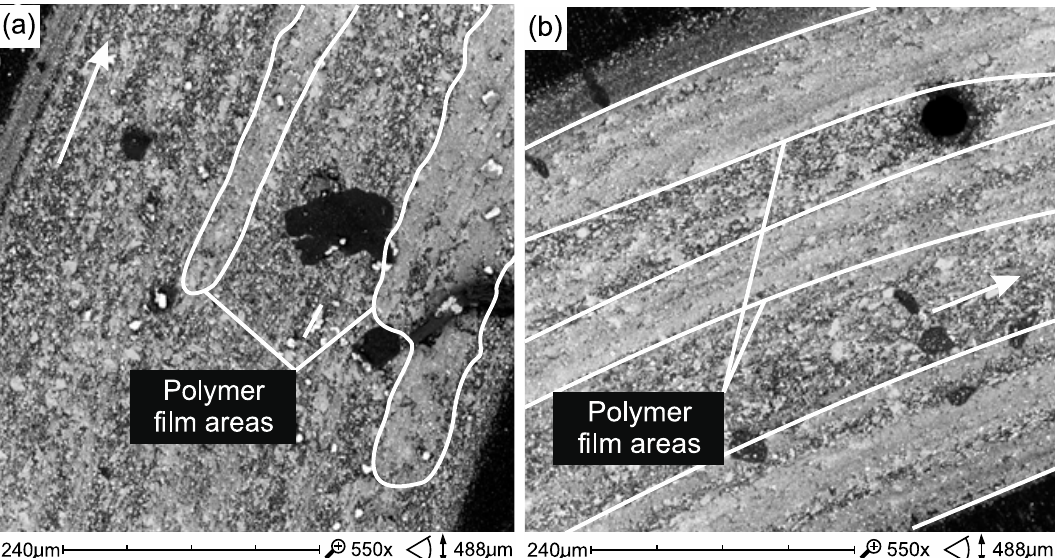
Figure 15. Surface of friction of Ex-flow(P) composite samples without ( a ) and after thermocycling ( b ). Direction of sliding marked by an arrow.